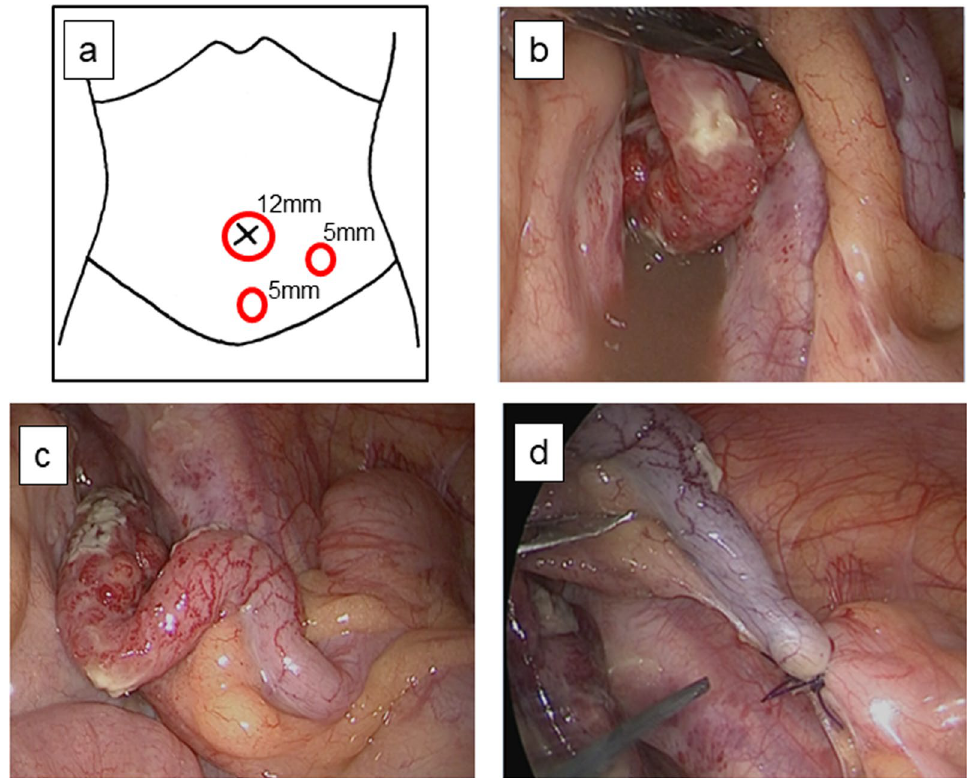
Fig. 2 Intraoperative findings. a Schematic illustration of the port layout. b The swollen and perforated appendix with an intact base was adherent to the surrounding tissue, and purulent ascites was present in the rectovesical pouch. c The intact appendicular base was identified